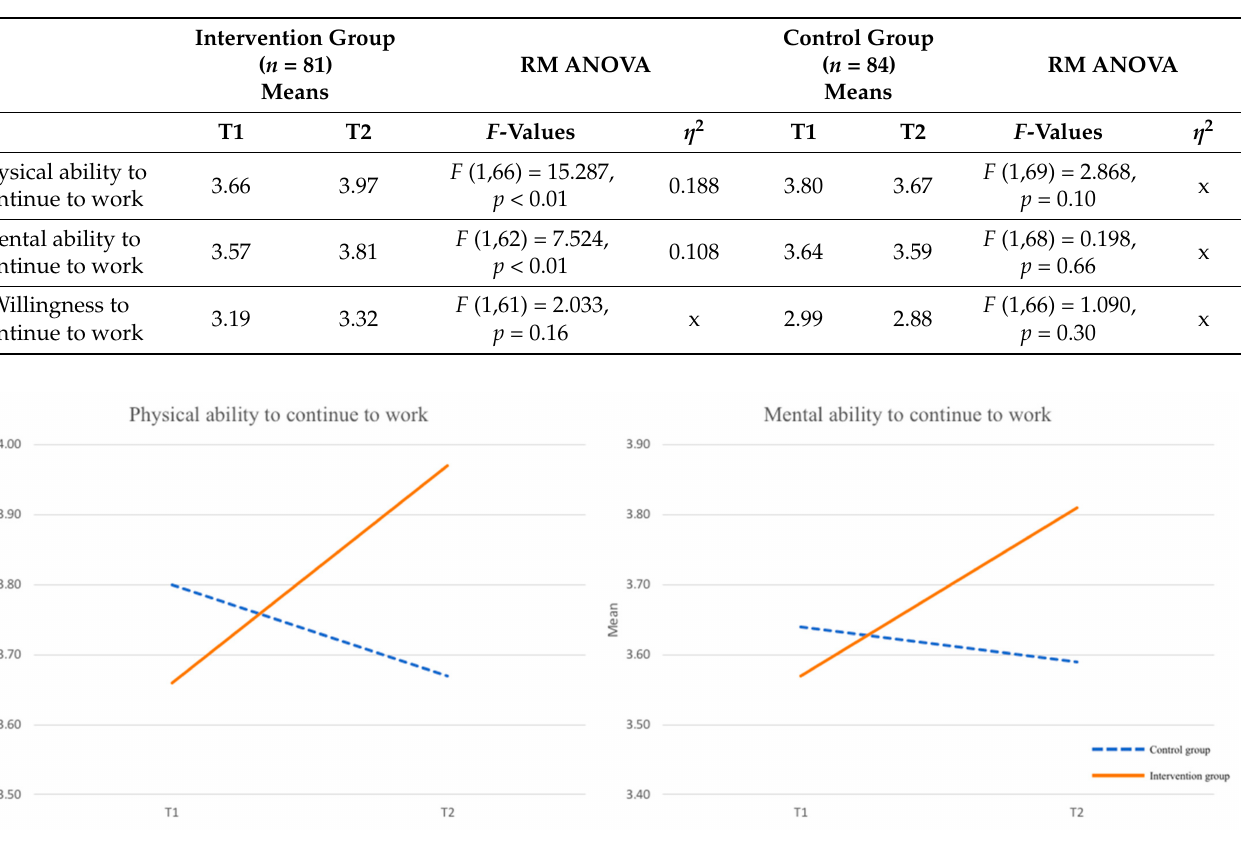
Figure 2. Results of RM ANOVAs for ability to continue to